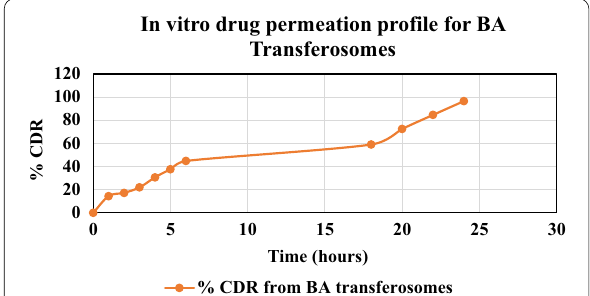
Fig. 14 Graphical representation of comparison profile of in vitro drug permeation